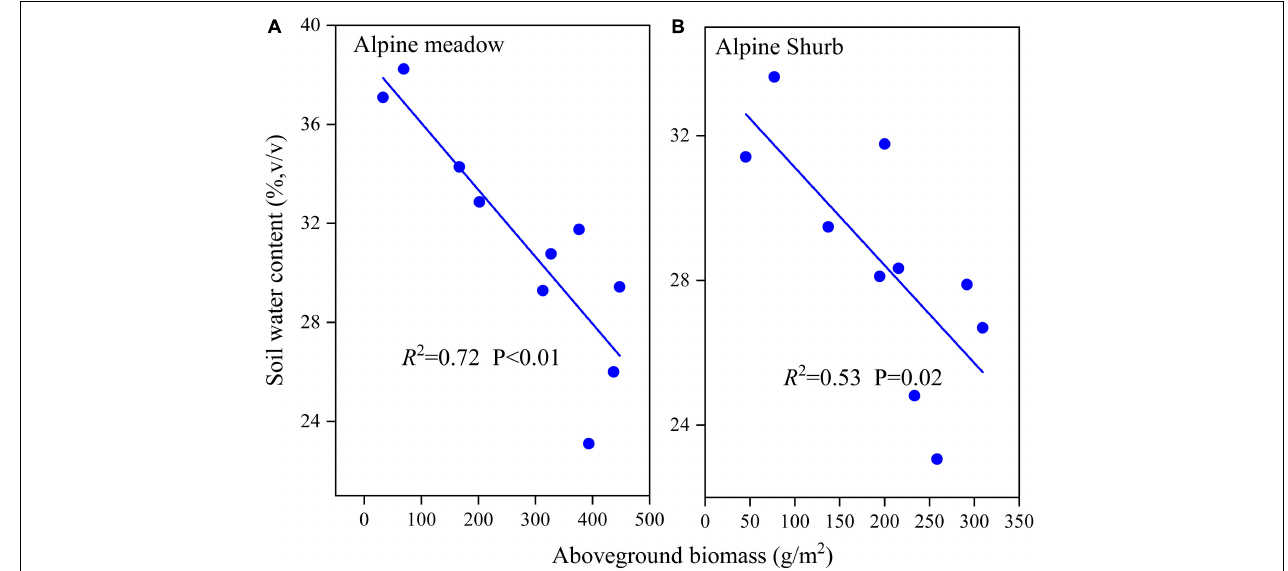
FIGURE 6 | The relationship between aboveground biomass and soil water content for alpine meadow (A) and alpine shrub (B) .